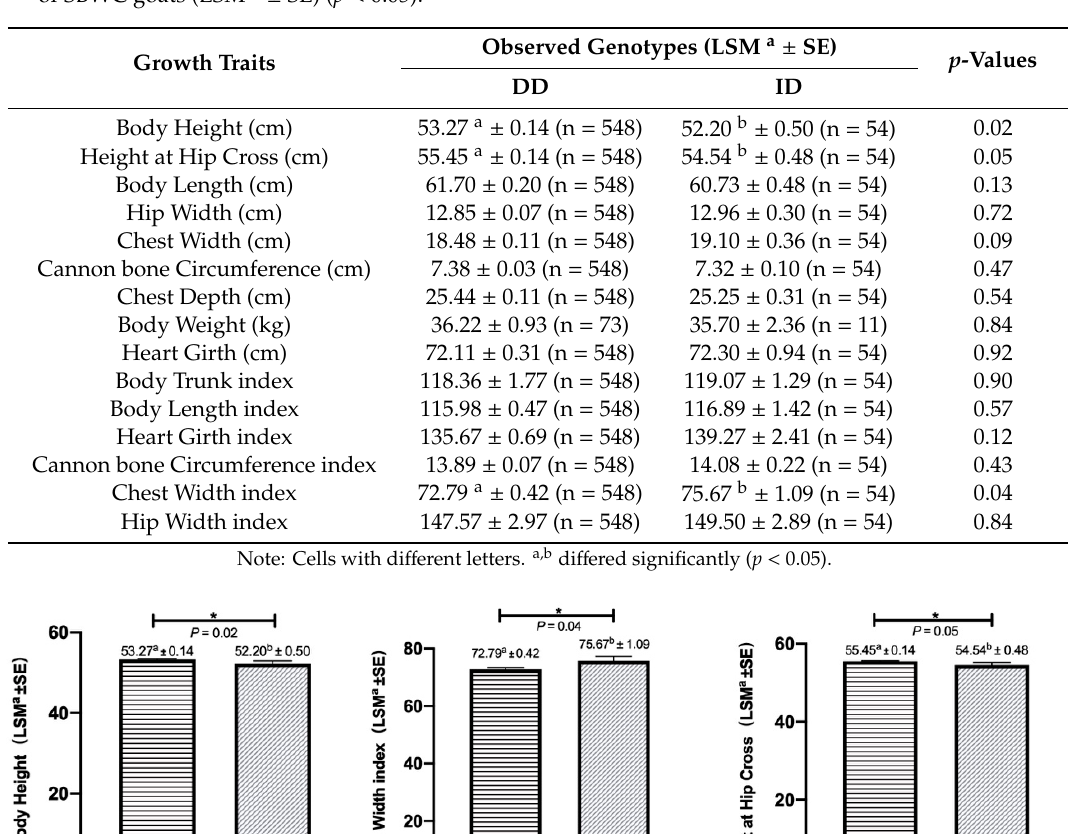
Table 2. Relationship between the 5 bp indel locus within the MSTN gene and the growth traits in kids of SBWC goats (LSM a ± SE) ( p < 0.05).